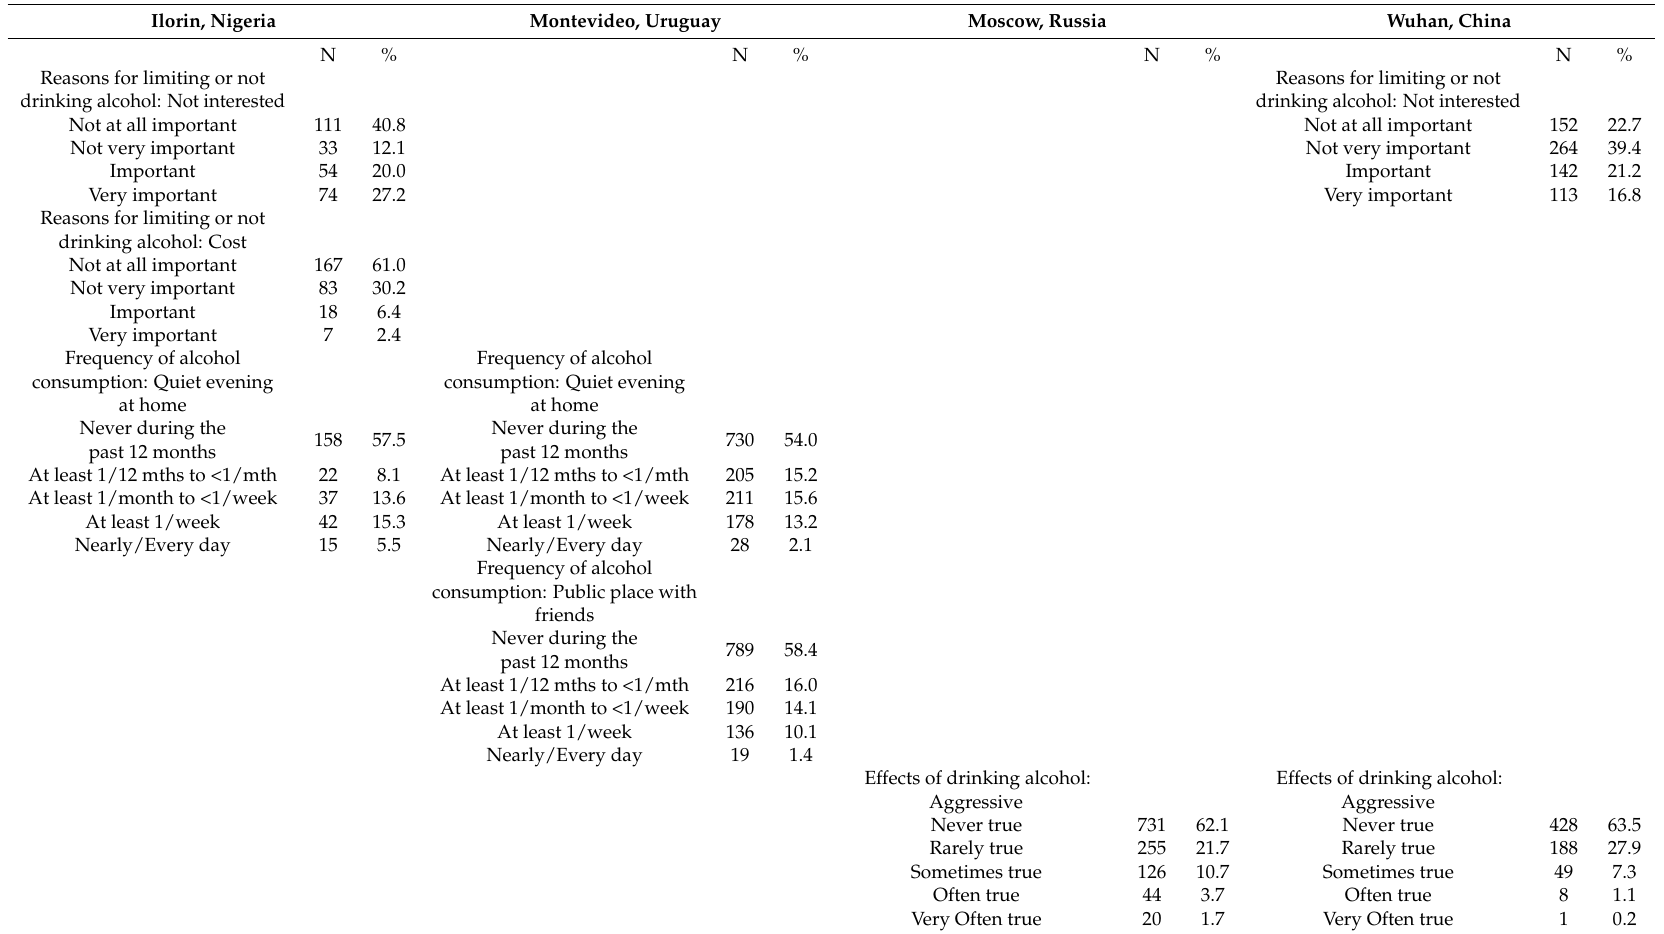
Table 3. The univariable associations of heavy episodic drinkers determined by city,